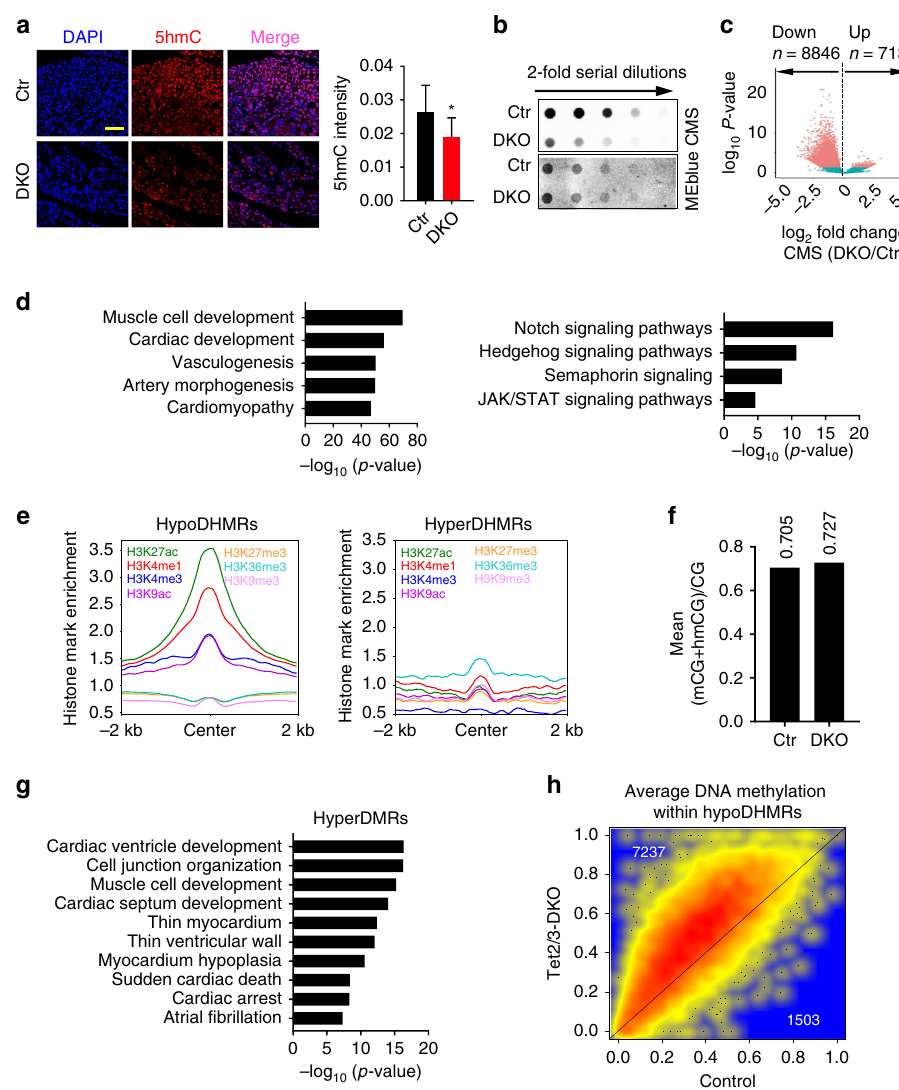
Fig. 4 Tet2/3 deletion in embryonic heart resulted impaired 5hmC but not 5mC. a (Left) Representative IF staining images for control and Tet2/3-DKO murine heart tissues collected at E12.5. Blue, DAPI; Red, 5hmC. (Right) Quanti fi cation of 5hmC levels in control and Tet2/3-DKO heart tissues collected at E12.5. Data were shown as mean ± S.D; n = 3 independent experiments (a total of 1038 and 1250 cells were analyzed for control and Tet2/3-DKO, respectively). ** p < 0.01 compared to control (two-tailed Student ’ s t -test were used). Scale bar: 50 µ m. b Measurement of the global 5hmC levels in control and Tet2/3-DKO heart tissues collected at E12.5 by using the dot-blot assay. Methylene blue (MEblue; bottom) staining was used to visualize the total DNA input. c Volcano plot illustrating the differentially enriched 5hmC regions (DHMRs) in E12.5 heart tissues between the control and Tet2/3-DKO groups ( p value < = 0.05). The mean size of hypoDHMRs was 593 bp, covering 0.18% of the genome. d Representative GREAT analysis on hypoDHMRs illustrated in Fig. 4c. Corrected binomial raw p-value were calculated. e Normalized enrichment of the indicated histone modi fi cations within identi fi ed hypoDHMRs (left) and hyperDHMRs (right). f Average DNA methylation levels in control and Tet2/3-DKO murine heart tissues collected at E12.5. g GREAT analyses on identi fi ed top 5000 most signi fi cant changed hyperDMRs in Tet2/3-DKO heart tissues compared with control. Corrected binomial raw p -value were calculated. h Scatterplot of the average DNA methylation levels within hypoDHMRs in E12.5 control and Tet2/3-DKO heart